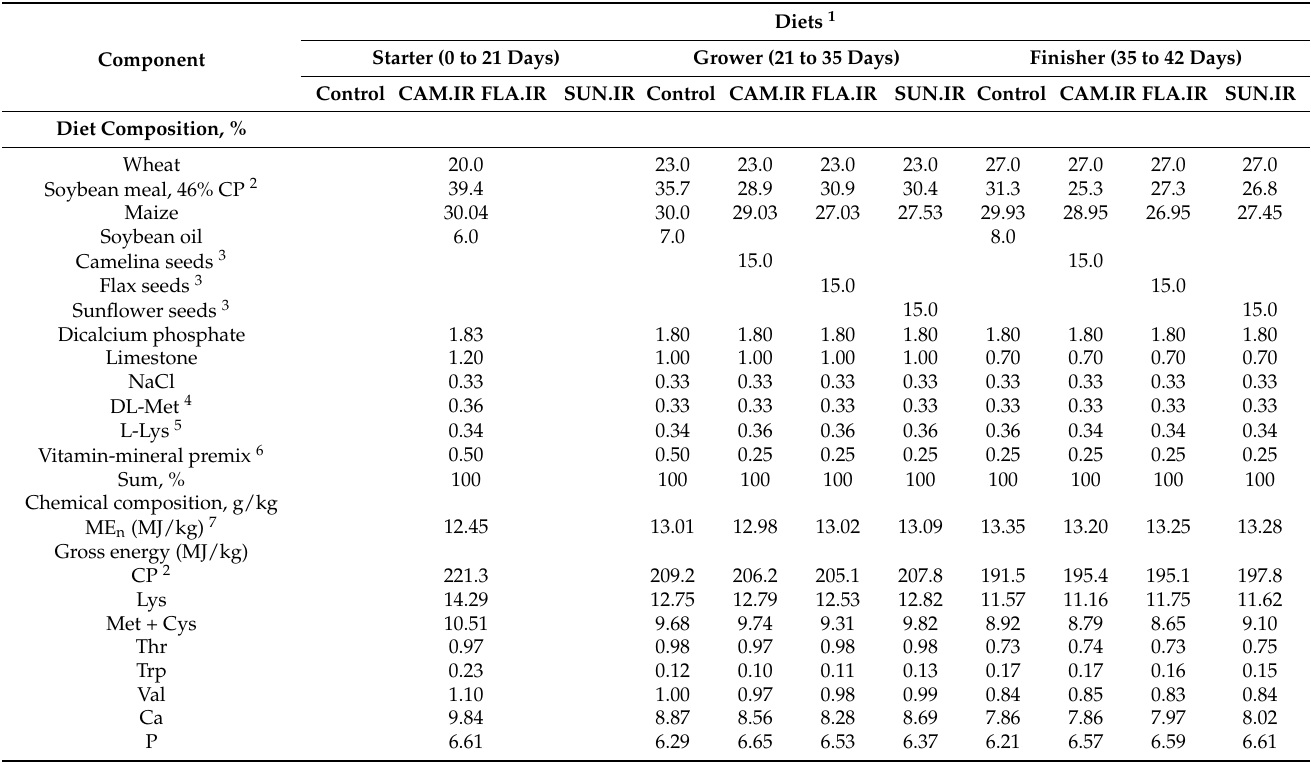
Table 2. Dietary ingredients and nutrient content in the experimental